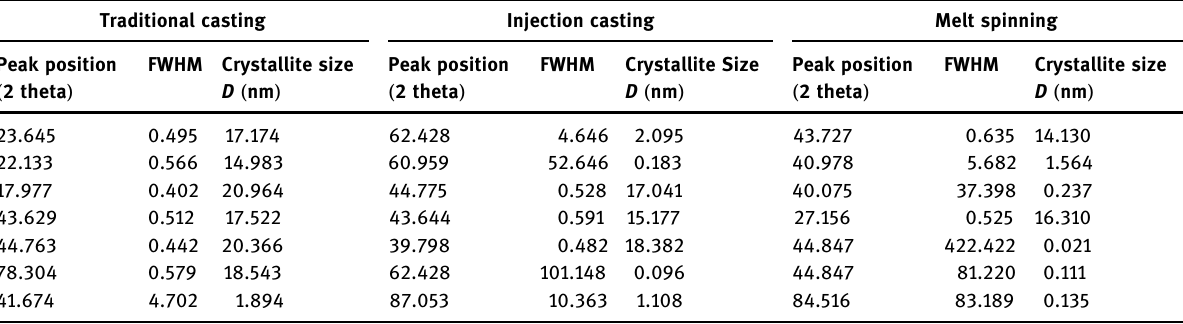
Table 2: Calculation parameters of crystallite size under three processes Traditional casting